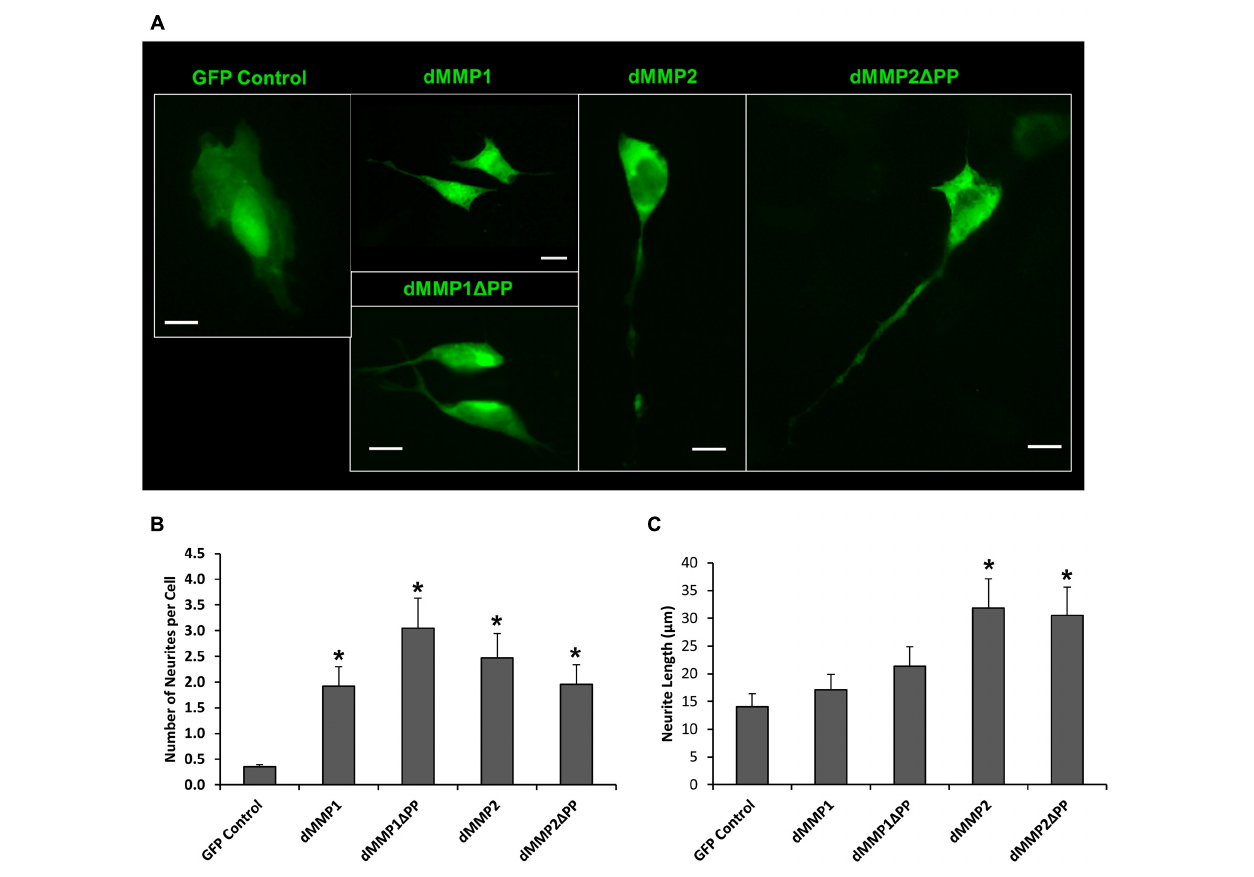
FIGURE 4 | GFP-dMMP expression induces neurite formation. (A) Neuron like morphology of SH-SY5Y cells transfected with GFP Control and GFP-dMMP constructs. Scale bar = 10 µ m. (B) Number of neurites per cell (Mean ± SE) in GFP Control and GFP-dMMP transfected cells. (C) Neurite length ( µ m) (Mean ± SE) in GFP Control and GFP-dMMP transfected cells. Data are averaged across three independent experiments. Bars with * represents significant difference compared to control at p < 0.05.